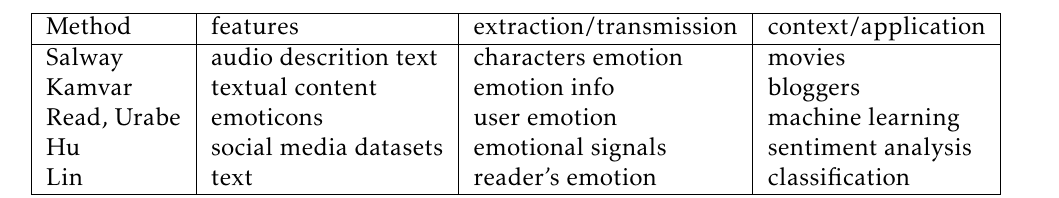
Table 3. Emotion extraction approaches on textual documents